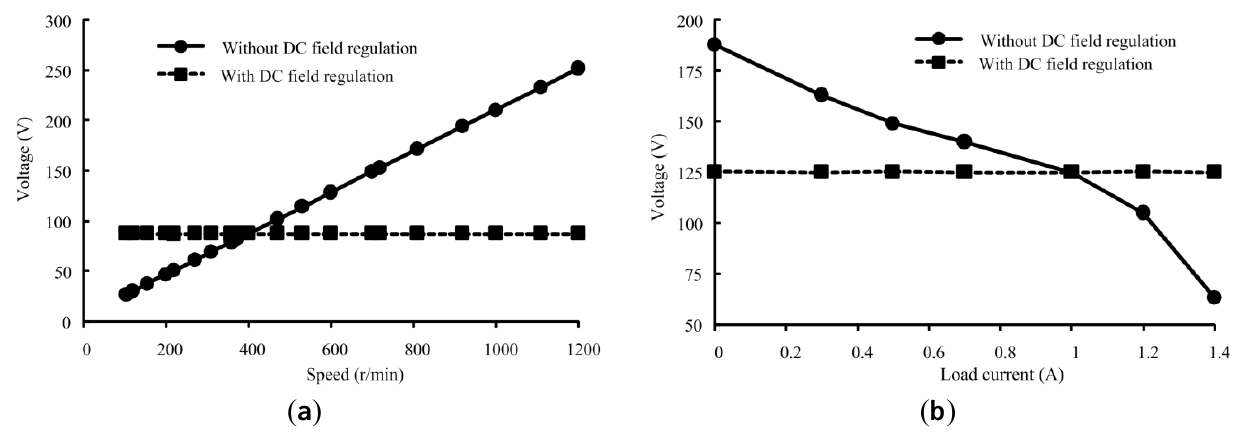
Figure 18. DC field regulation of the ISG (hybrid-excitation stator-PM motors). ( a ) Voltage versus speed; ( b ) Voltage versus load